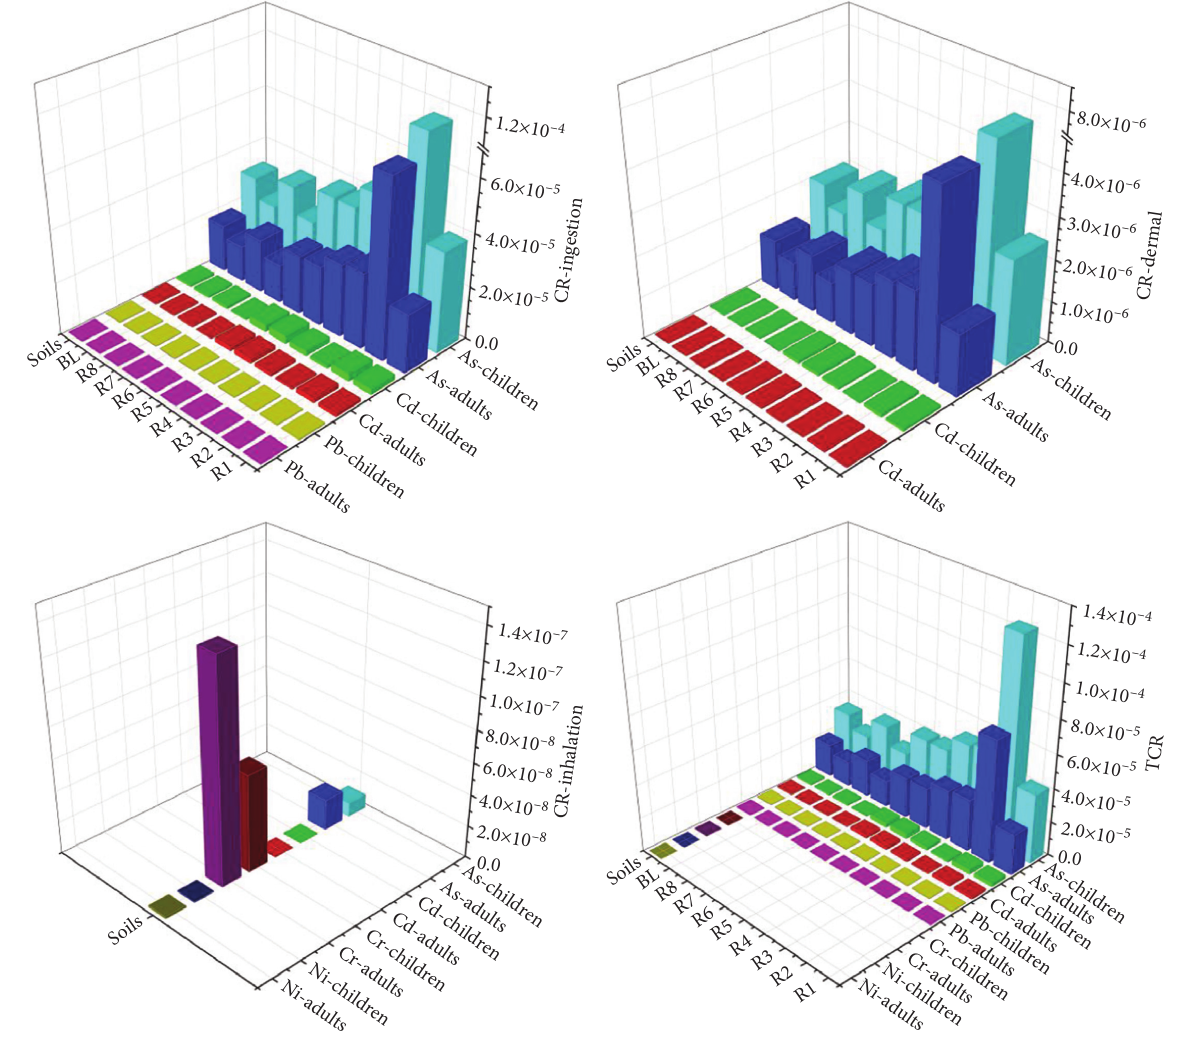
Figure 8: The carcinogenic risk (CR) and total carcinogenic risk index (TCR) of the study area in sediments and